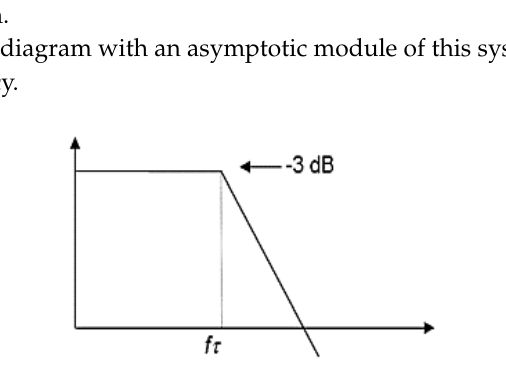
Figure 2. Bode diagram of the system.